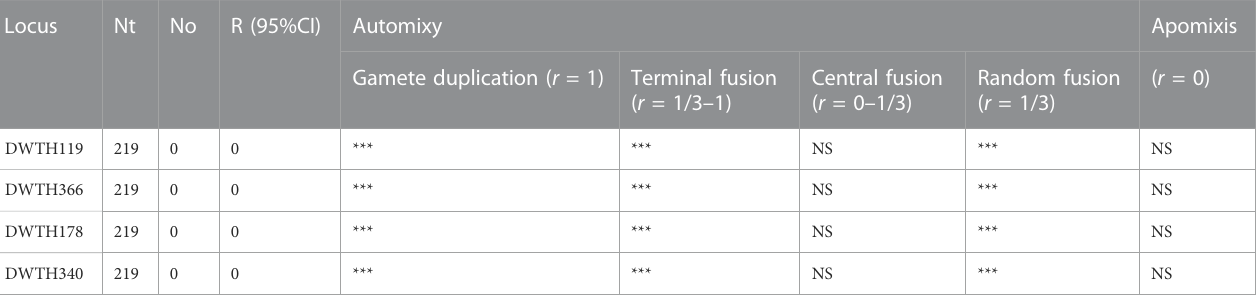
TABLE 5 Observed frequencies of heterozygous transition to homozygous loci for thelytokous D. wani , and agreement with theoretical frequencies under different cytological genetic mechanisms.